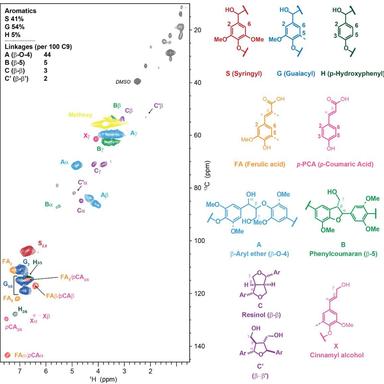
HSQC analysis of the lignin PSS1 isolated after pilot scale soda pulping of Miscanthus x giganteus.